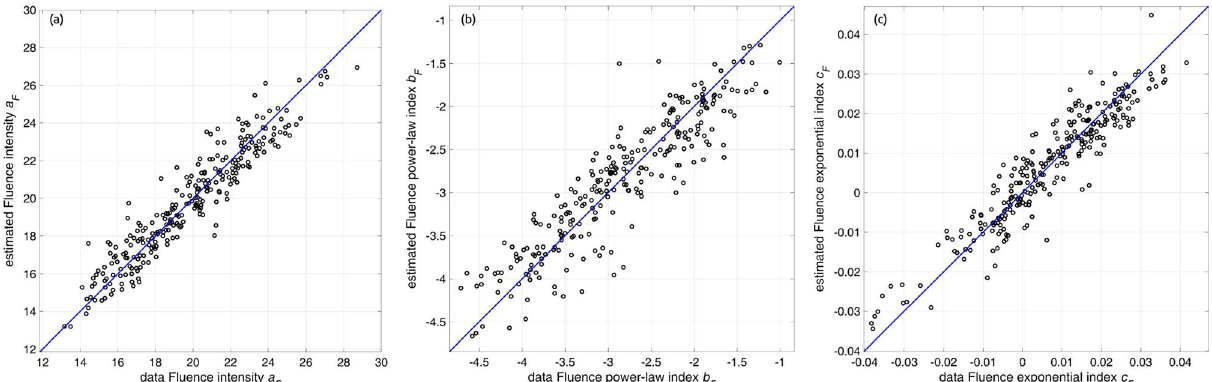
Fig. 6. Cross-plots of Fluence spectral parameters derived from data and estimated from the estimator hypersurfaces, y = x equality lines are in blue. (a) Fluence spectrum intensity a F , (b) Fluence power-law index b F and (c) Fluence exponential index c F